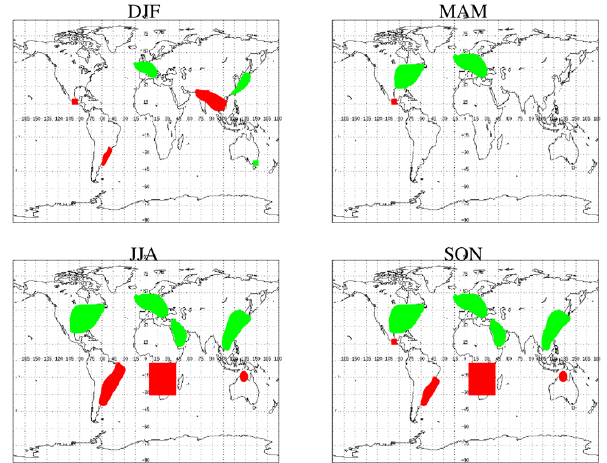
Fig. 7. New fine model map for four seasons: Northern Hemisphere winter, spring, summer, fall. For each map, over land regions, red (green) mark where strongly absorbing (weakly absorbing) aerosol models are assumed. Areas with no color are assumed as moderately